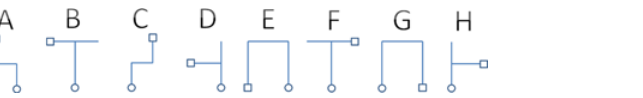
Fig 2. The virtual mazes. A sketch of the eight virtual mazes that participants were asked to traverse (marked as mazes A-H). A circle ( ◦ ) denotes the starting point of the maze, and a square ( □ ) denoted the end point